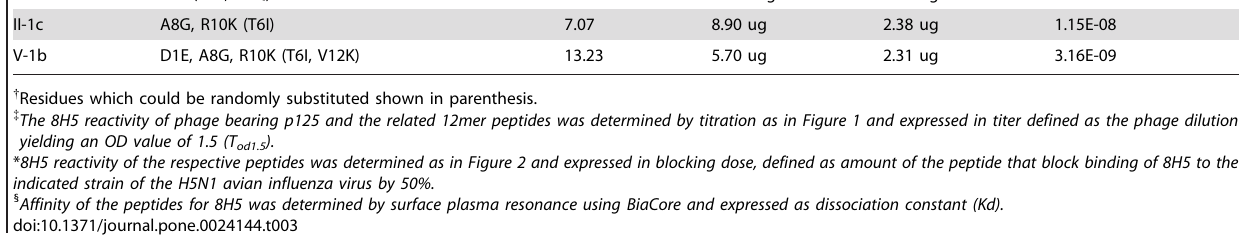
Peptide Amino acid substitutions { Titer {